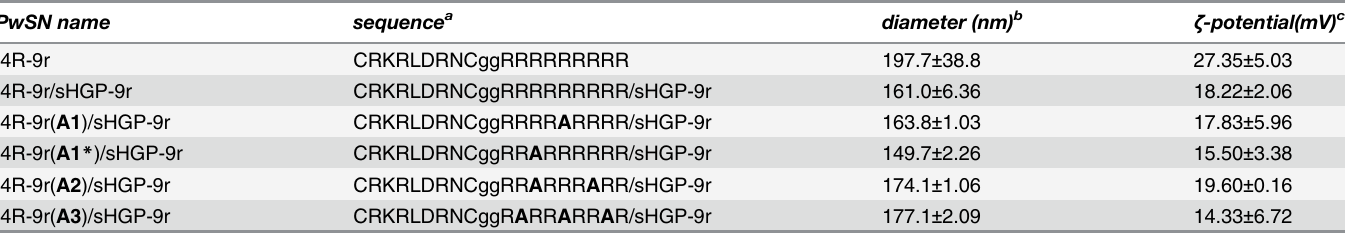
a sHGP-9r (RGWEVLKYWWNLLQYggRRRRRRRRR) is blended with I4R-9r/sHGP-9r PwSN with 1:19 molar ratios (sHGP-9r: I4R-9r). gg; Gly-Gly linker. Substituted alanine was highlighted by red. b Mean hydrodynamic size based on dynamic light scattering measurements. Errors indicate SD from at least three separate measurements. c Zeta-potential of nanocomplexes. Errors indicate SD from at least three independent measurements.